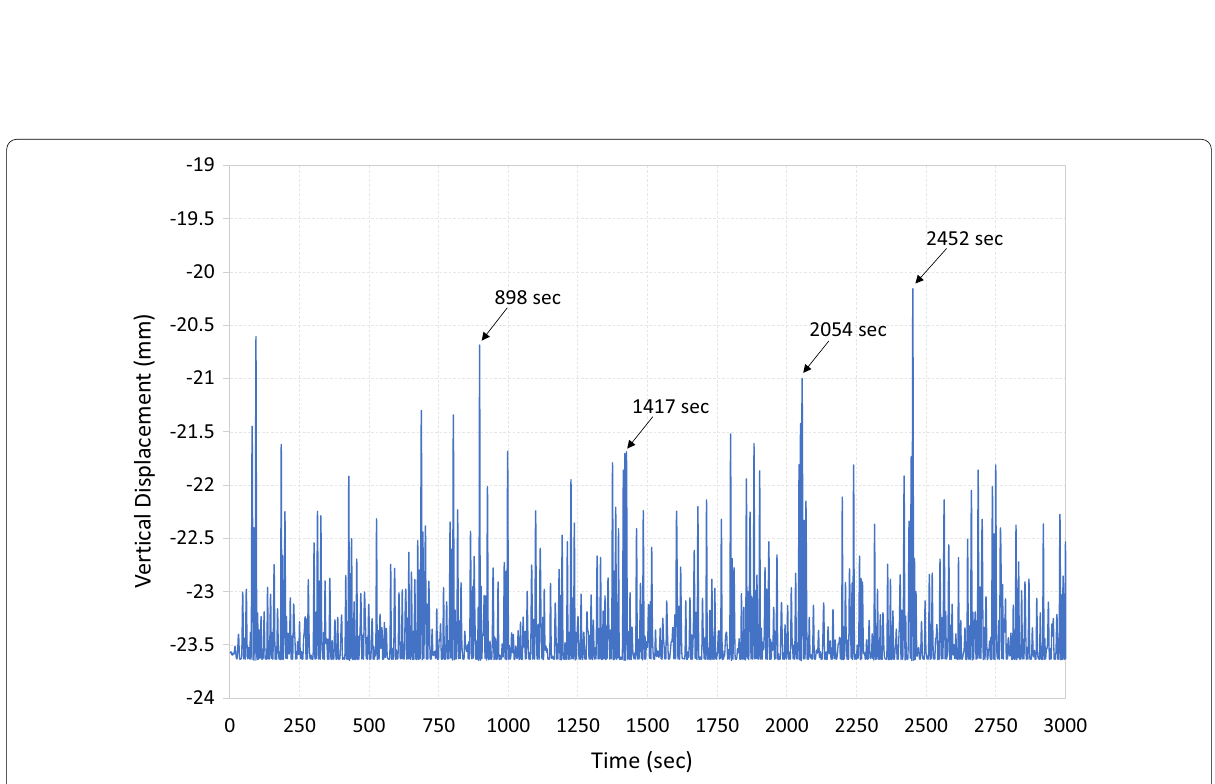
Fig. 12 Time history of the vertical displacement for the pipeline right end for 180 mm concrete coating